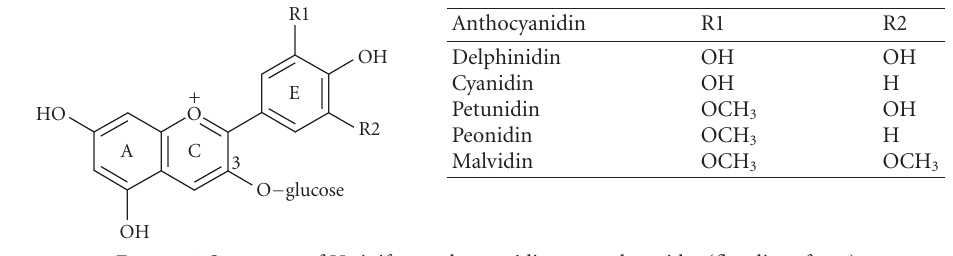
Figure 1. Structures of V vinifera anthocyanidin monoglucosides (flavylium form).